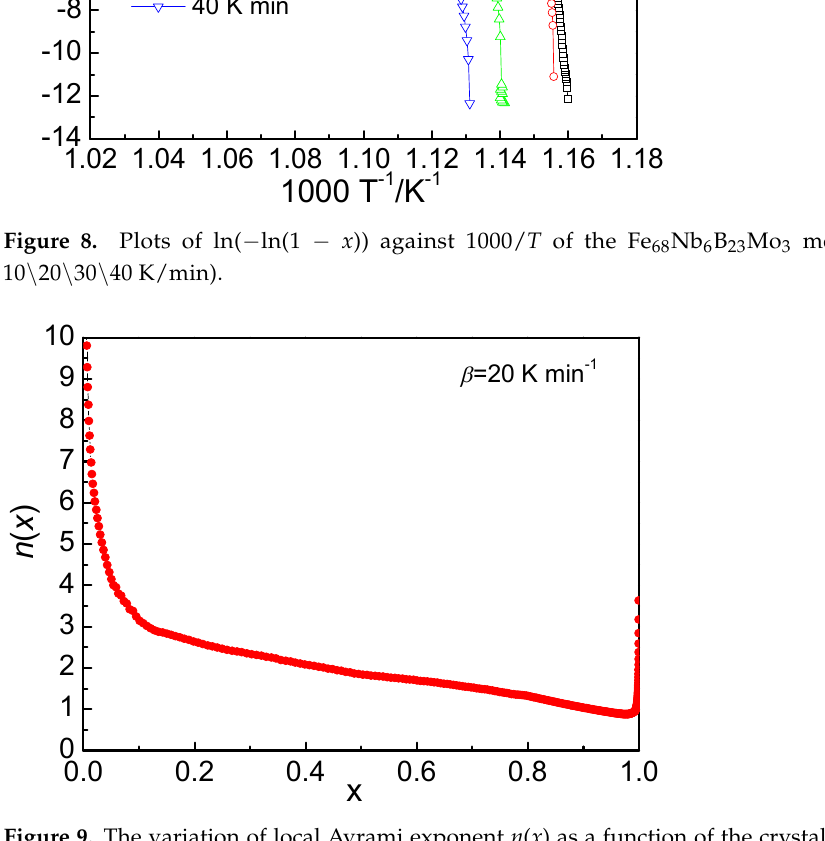
Figure 9. The variation of local Avrami exponent n ( x ) as a function of the crystallization volume fraction at heating rate of 20 K/min.